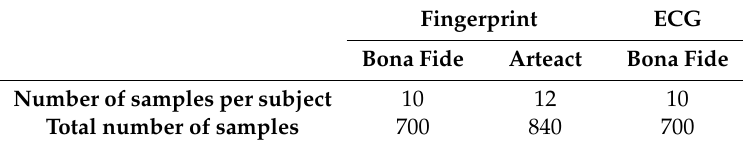
Table 3. Description of the customized multimodal dataset, which contains 70 subjects.